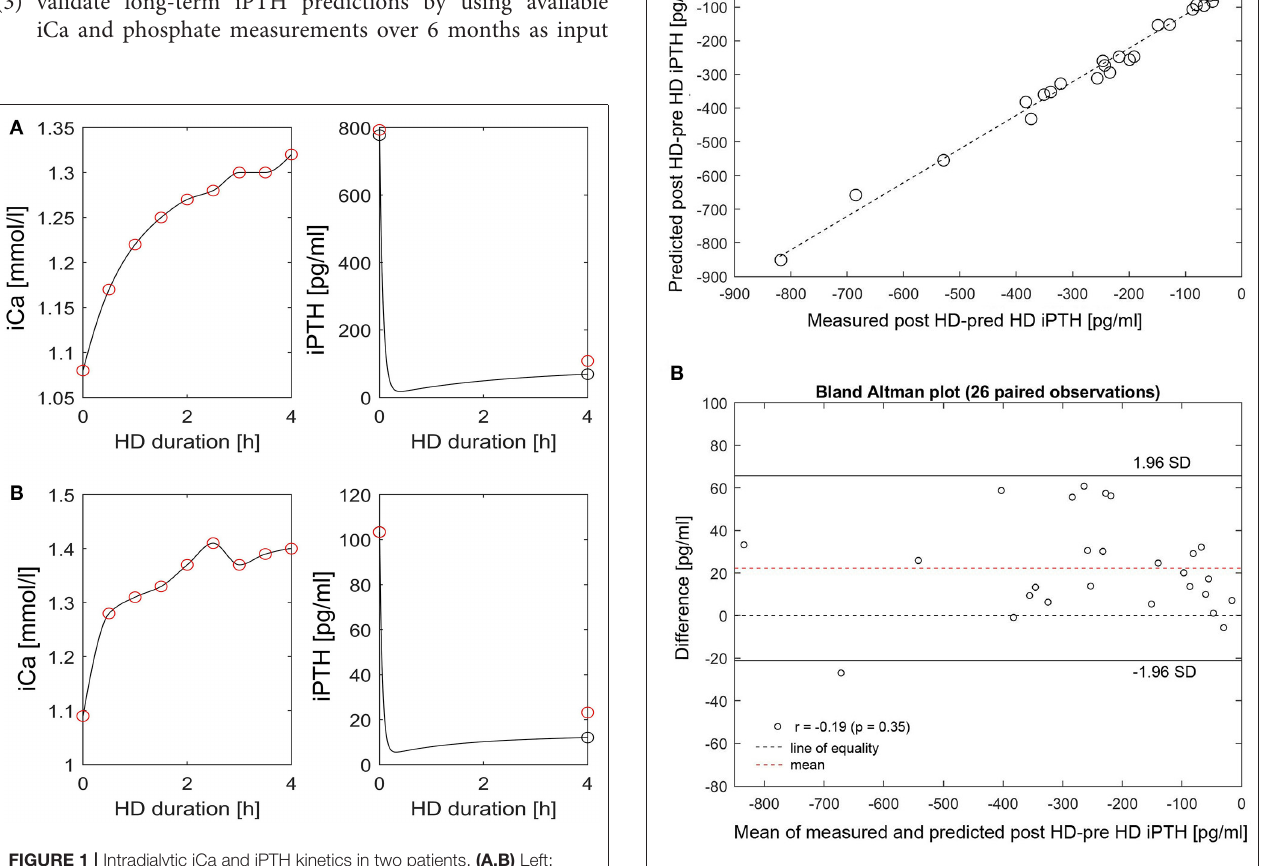
FIGURE 2 | (A) Correlation between measured and predicted post-minus-pre HD iPTH ( n = 26). ( B) Bland Altman plot for differences between measured and predicted post-minus-pre HD iPTH. (A) Measured (x-axis) and predicted (y-axis) peridialytic iPTH change (r = 0.984, p < 0.001). The peridialytic change was calculated as post-HD iPTH minus pre-HD iPTH levels. HD, hemodialysis; iPTH, intact parathyroid hormone; SD, standard